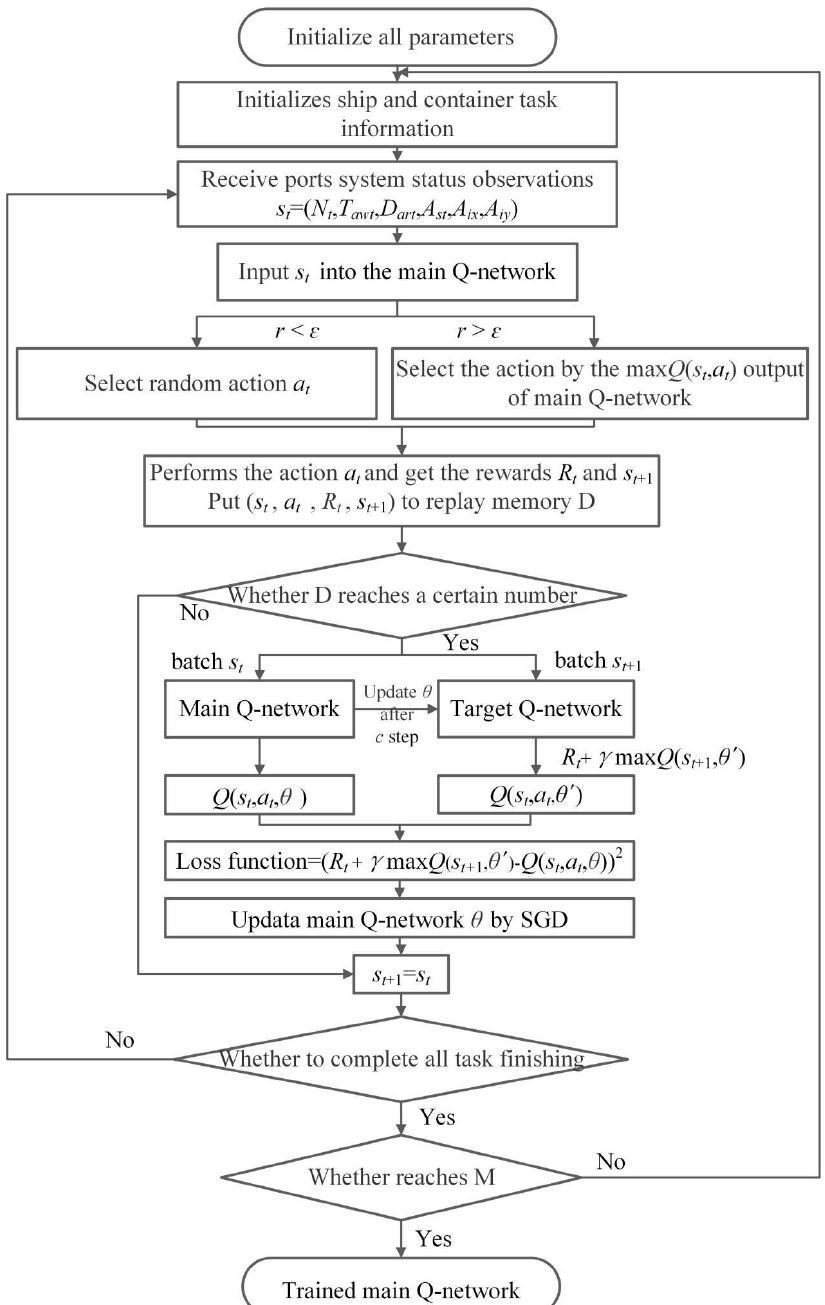
Figure 3. DQN training